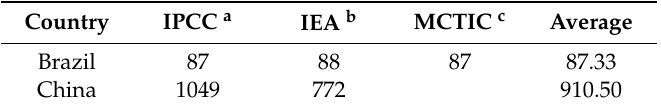
Table 3. Emission factors of the countries in g CO 2